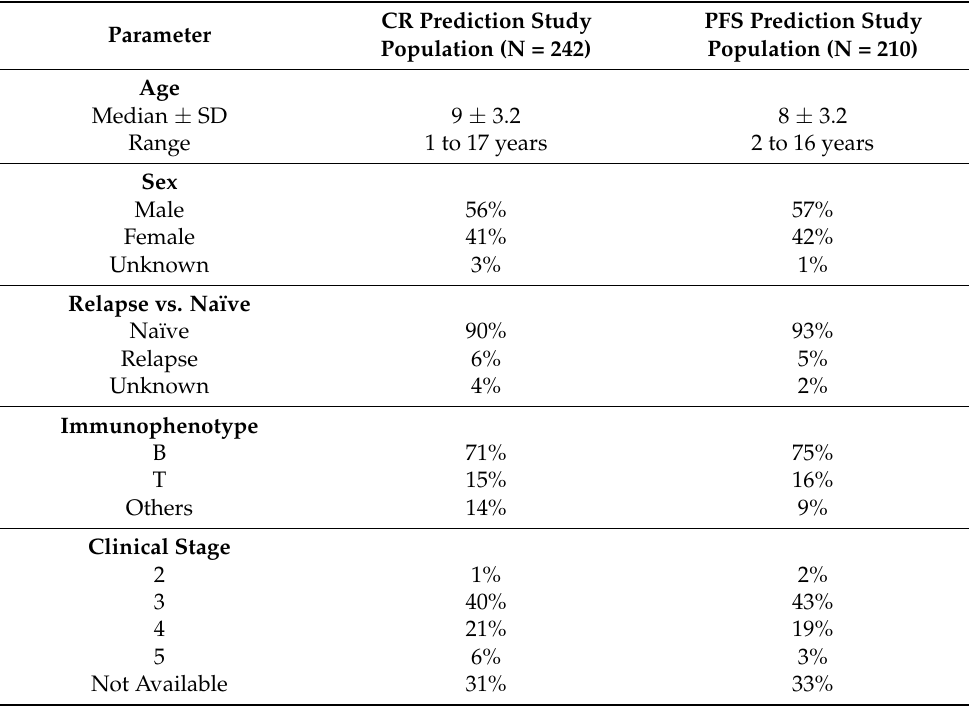
Table 1. Characteristics of the patients included in this retrospective